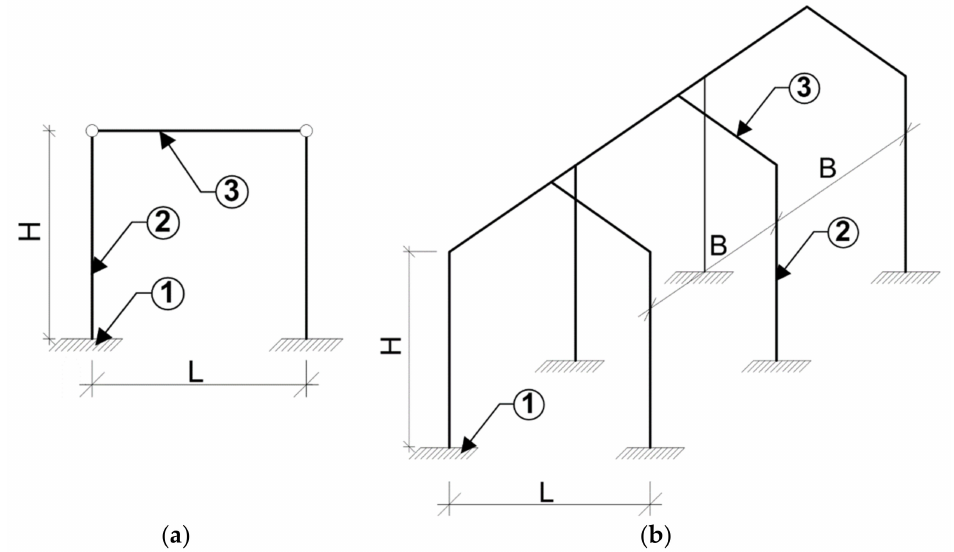
Figure 1. Scheme of the structural system of a single-nave hall building: ( a ) static diagram, ( b ) axonometric view; 1—foundation, 2—column, 3—girder, L—span of the nave, B—column spacing in the hall.